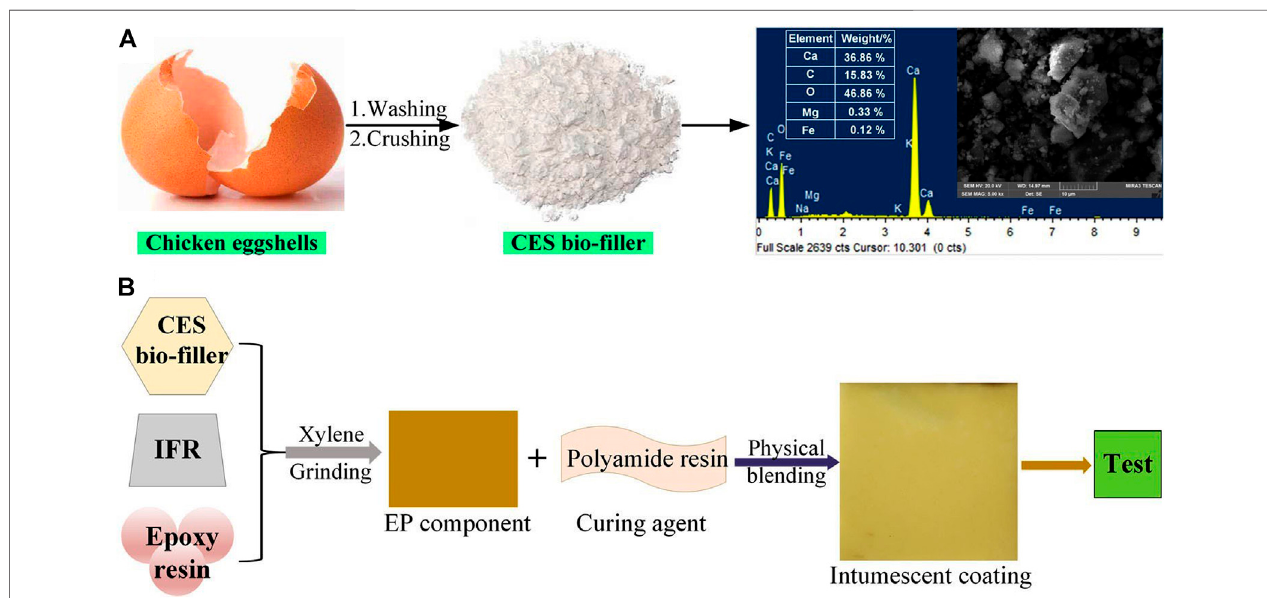
FIGURE 6 | Illustration for (A) the preparation of CES bio- fi ller and (B) fabrication of CES-containing intumescent fi re-retardant epoxy coatings (Xu et al., 2018).